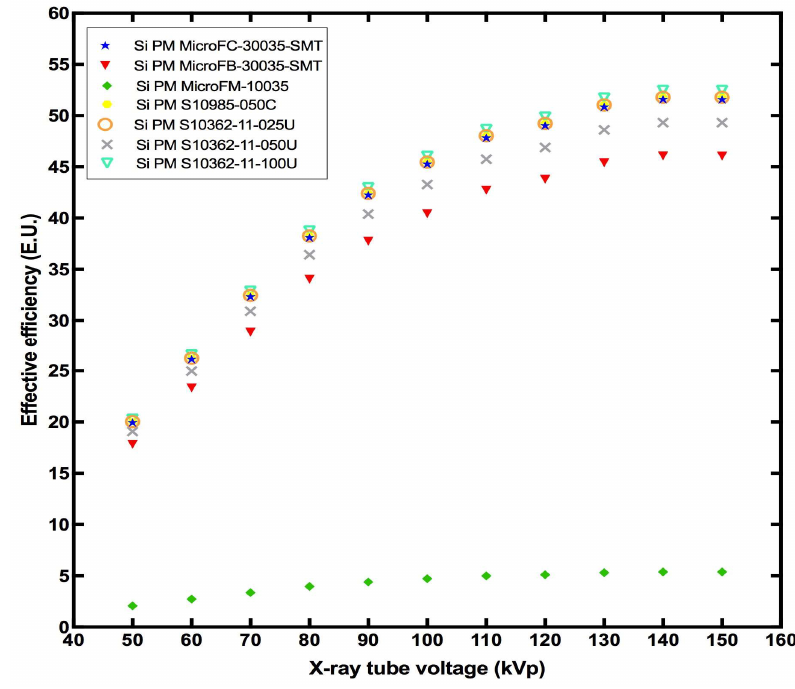
Figure 18. EE of the LaBr 3 :Ce combined with various Si PMs.